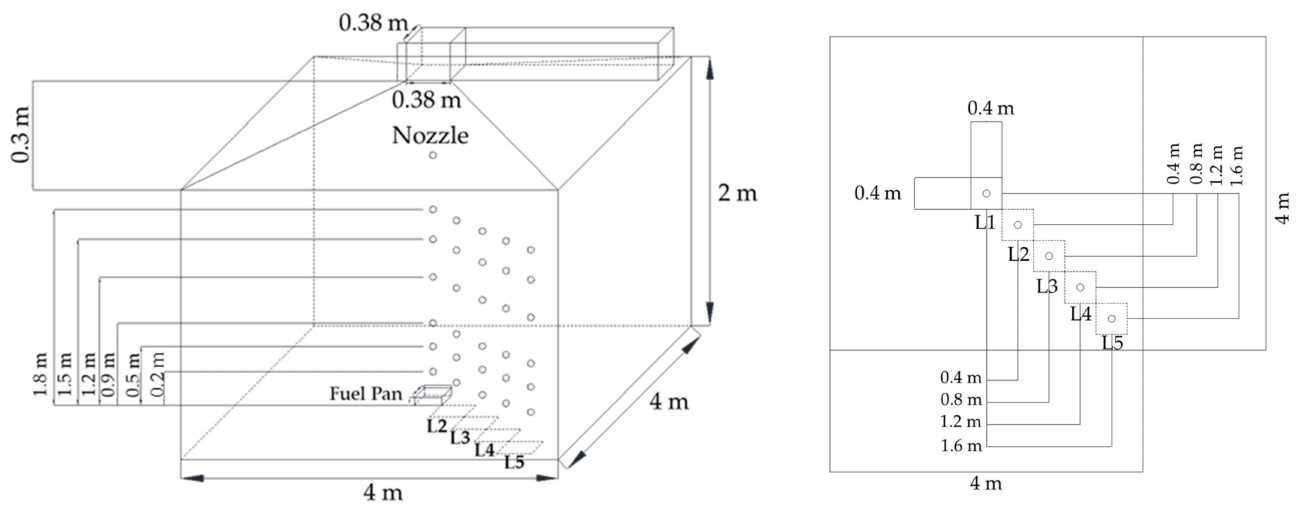
Figure 1. Schematic of the testing